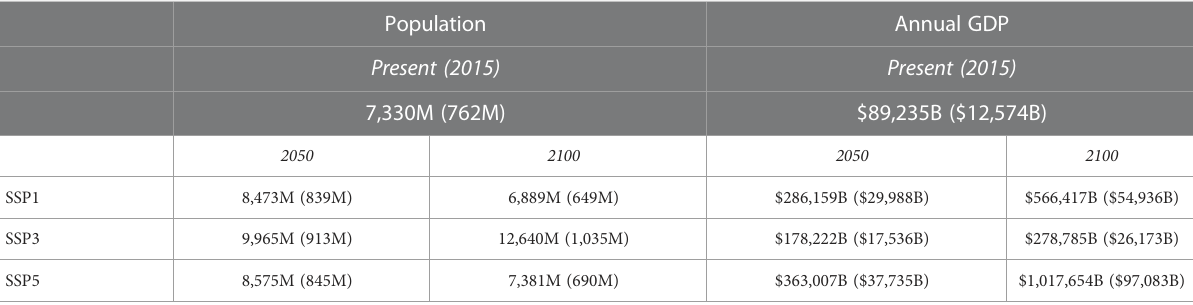
TABLE 1 Global and Low Elevation Coastal Zone (shown in parentheses) population and GDP estimations (Billions of US$ in 2005 currency) for various Shared Socio-economic Pathway (SSP)